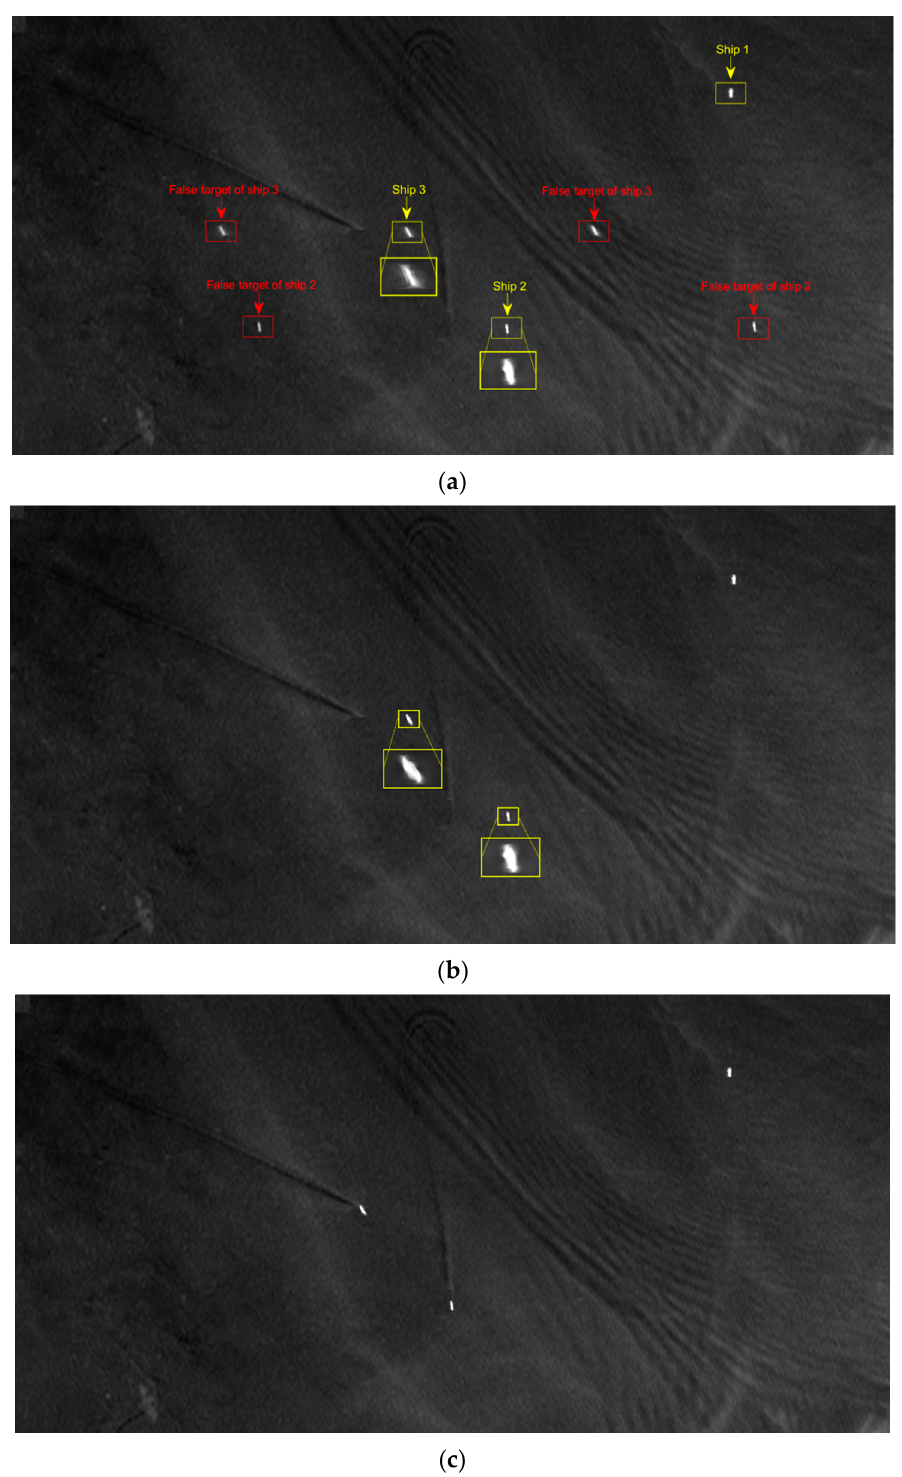
Figure 18. Comparison of the imaging results of the designed distributed ocean scene. ( a ) Imaging result obtained from the conventional azimuth multichannel reconstruction approach. ( b ) Imaging result obtained from the proposed multichannel reconstruction approach. ( c ) Imaging result after location correction.